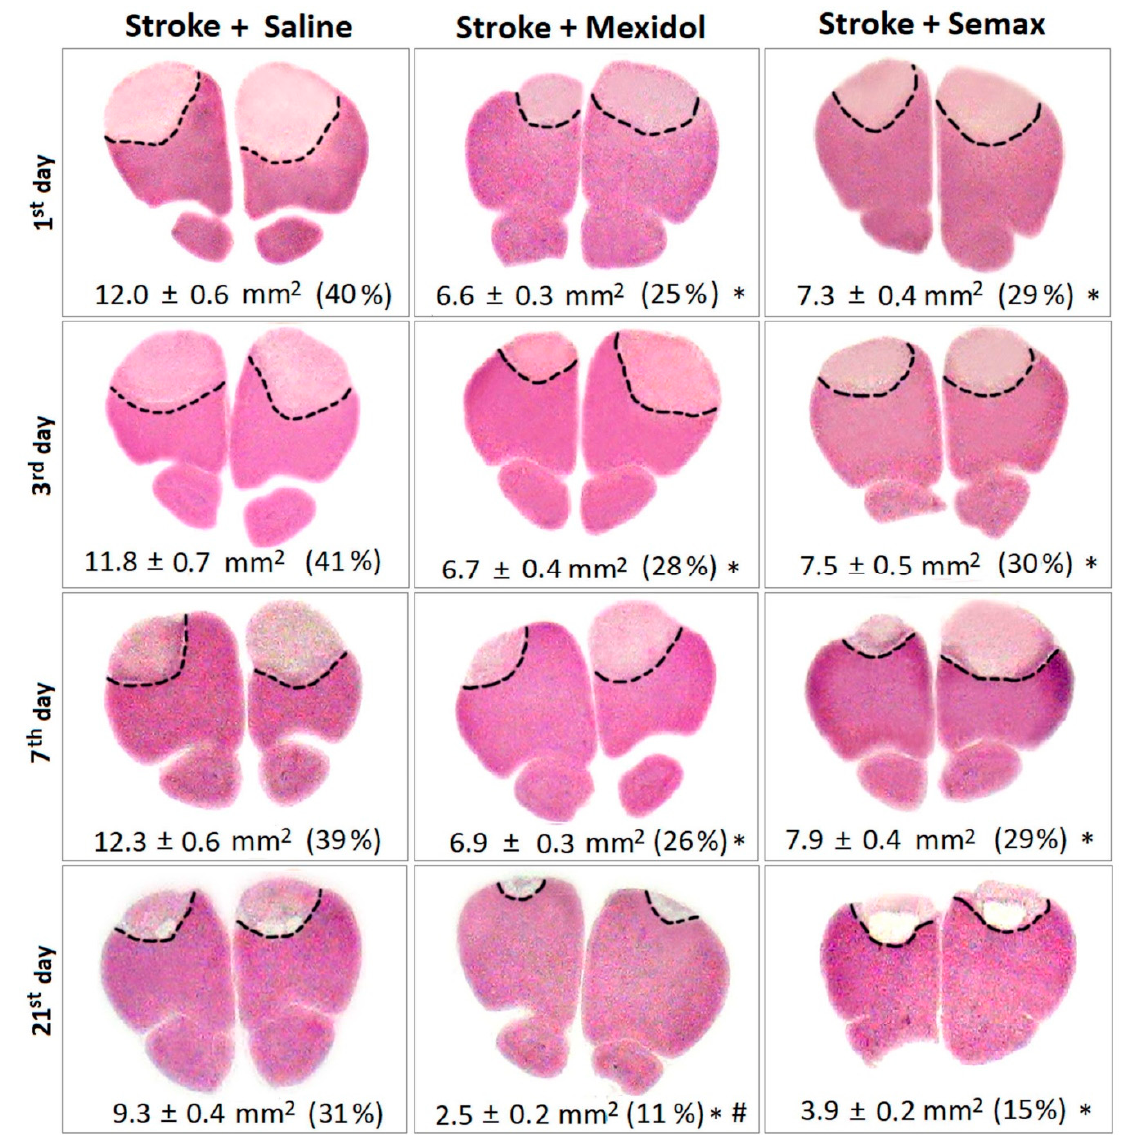
Figure 3. Dynamics of the development of ischemic damage of the prefrontal brain cortex in rats during the 7-day course of Mexidol or Semax treatment and 14 days after drug withdrawal. Photographs of rat prefrontal cortex slices were taken in the region with maximal cortex damage (at the level of 4.2 mm from the bregma) [62]. The slices were stained with hematoxylin and eosin (H&E). The border of the infarct area is marked with a dashed line. Under each image, the values of the sum of the damaged areas in both hemispheres are indicated, and the damaged area as a percentage of the prefrontal cortex is indicated in brackets. * p < 0.05 denotes a significant difference from the Stroke + Saline group at the appropriate time period; # p < 0.05 denotes a significant difference between the Stroke + Mexidol with Stroke + Semax groups at the appropriate time periods based on a two-way ANOVA with Bonferroni’s post-hoc multiple comparison test.